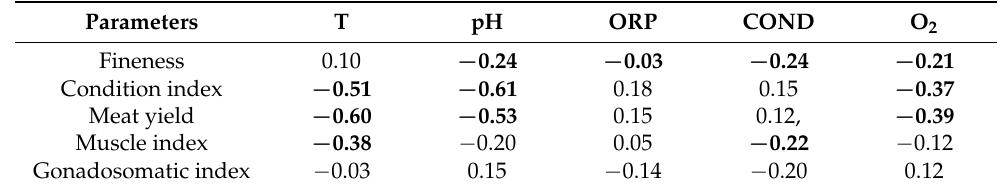
Table 3. Pearson correlation of A. opercularis morphometry and indices with seawater parame- ters: temperature (T), pH, ORP (oxydo-reduction potential), conductivity (COND), oxygen (O 2 ). Statistically significant differences are ( p < 0.05) represented in bold.